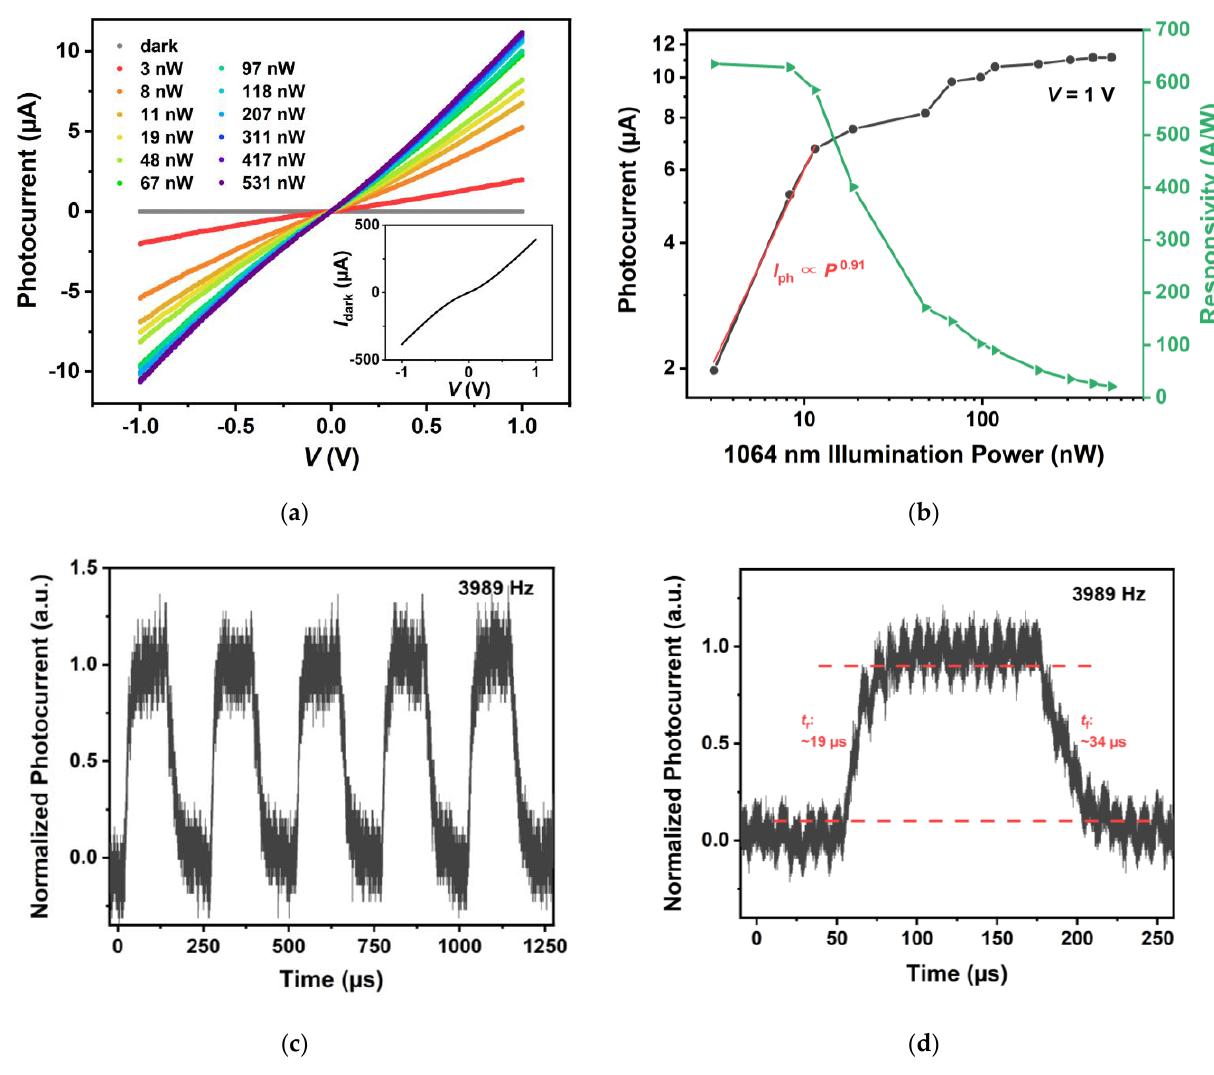
Figure 5. The photoresponse performance of device 1: ( a ) the photocurrent ( I ph )–voltage ( V ) curves under 1064 nm laser illumination with different illumination power ( P ) from 3 nW to 531 nW. Inset: The current ( I )– V curve under dark conditions; ( b ) the I ph and illumination power relation (the black line), and the responsivity ( R ) and illumination power relation (the green line) measured at V = 1 V. The red line is the fitted curve with the equation I ph = aP b , where a and b are fitted constants; ( c ) the normalized photocurrent waveform under chopped 1064 nm laser illumination. The chopping frequency is 3989 Hz; ( d ) a single normalized response cycle. The rise (fall) time t r ( t f ) of 19 µ s (34 µ s) is